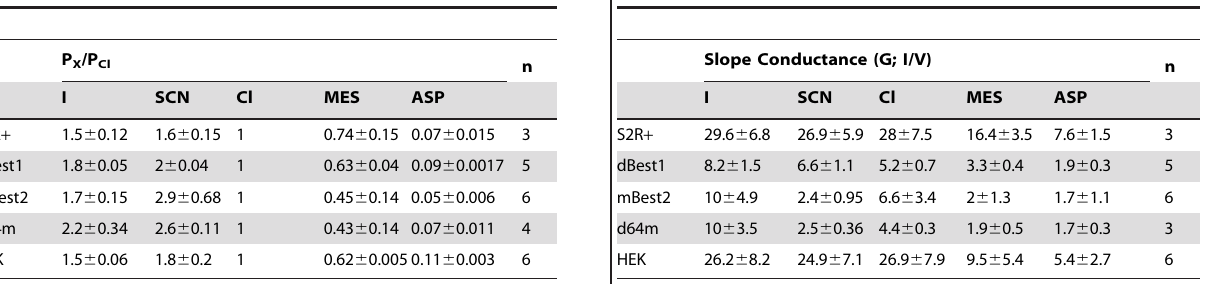
Table 1. Relative Permeabilities. Table 2. Slope